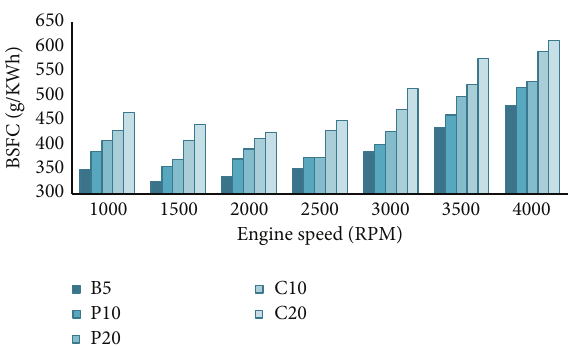
Figure 4: Variation of BSFC for all tested blends at 100% load.